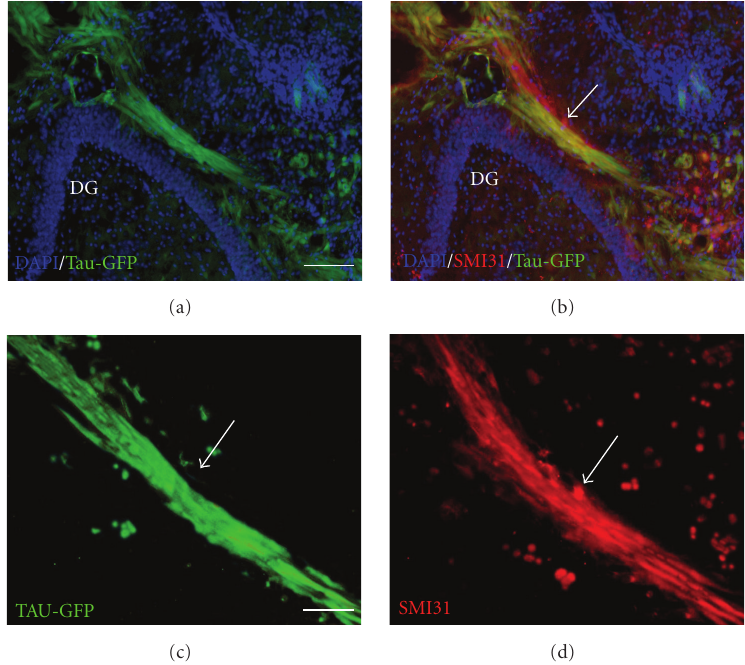
Figure 3: Projection from neurosphere-derived cells towards the lesioned entorhino-hippocampal formation. (a) A strong transplant- derived GFP-positive fiber bundle extends towards the dentate gyrus of the hippocampus in the area of the outer molecular layer. Scale bar = 50 μ m. (b) Combined image of GFP and SMI-31 confirms that the GFP-expressing fiber bundle (arrow) contains SMI-31-positive axons. (c) High magnification of GFP-positive fibers (arrow) from the transplant in the area of the hippocampal fissure and the outer molecular layer of the dentate gyrus. Scale bar = 100 μ m. (d) SMI-31 staining of GFP-positive fibers (arrow) from the